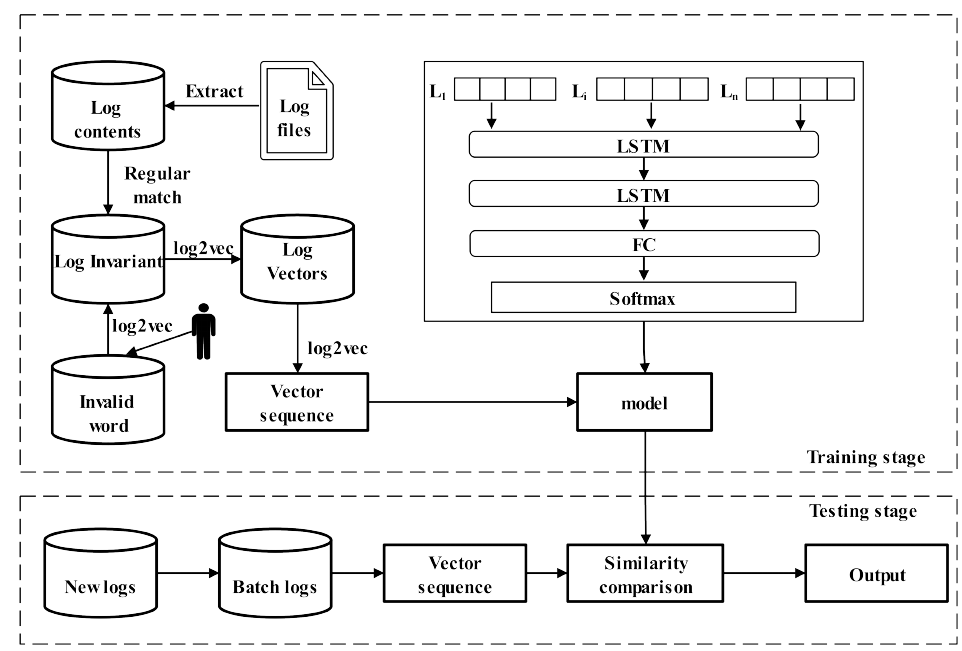
Figure 2. The framework of ConAnomaly.